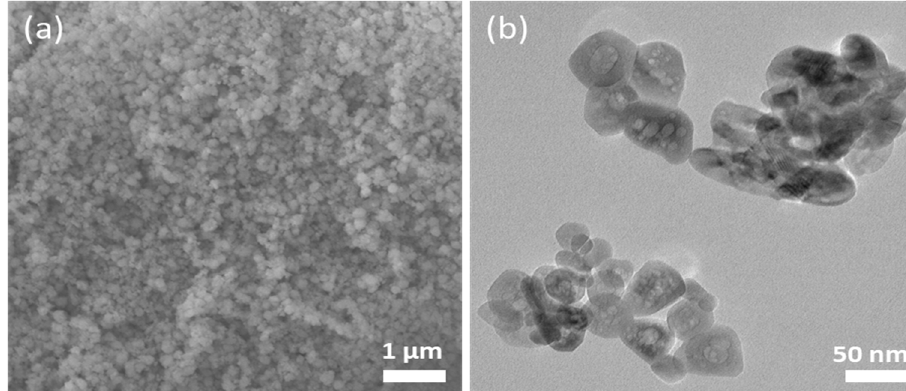
Figure 1. ( a ) SEM and ( b ) TEM images of the IONPs.